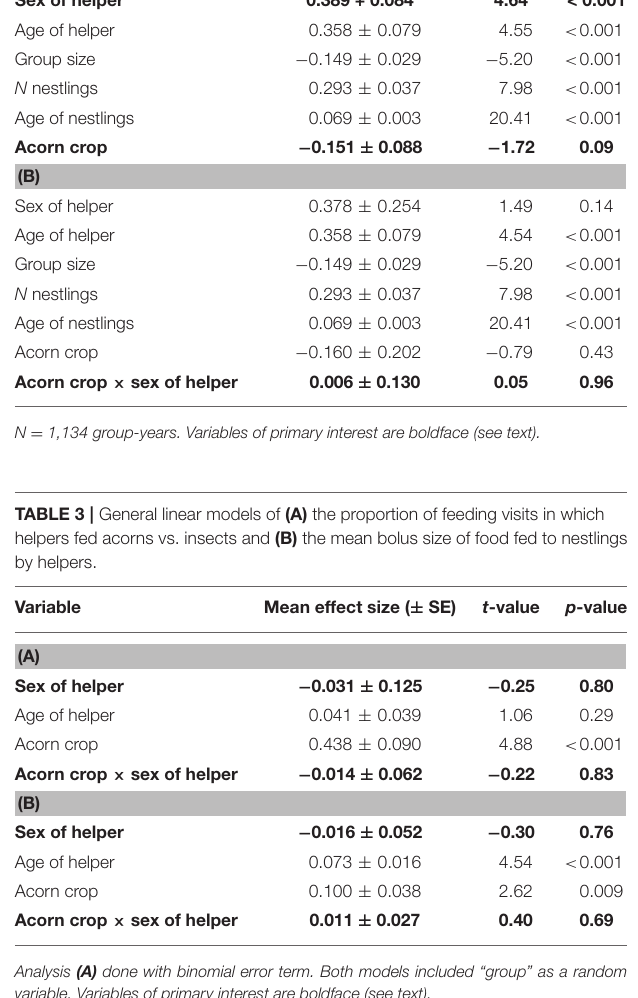
rates of helpers ( Table 2A ). In the parallel model including the interaction between the acorn crop and sex of helper the interaction was not significant ( Table 2B ). acorns increased significantly when the prior autumn’s acorn crop was larger ( Table 3A ), and the mean bolus sizes fed to nestlings increased both with the size of the prior autumn’s acorn crop and the age of helpers ( Table 3B ). In neither case, however, was there a significant difference between male and female helpers, nor was there a significant interaction between size of the prior autumn’s acorn crop and sex of the helper ( Table 3